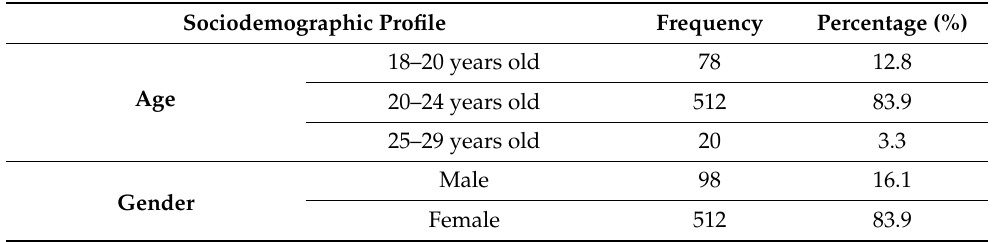
Table 1. Sociodemographic profile of participating undergraduate pharmacy students (n =